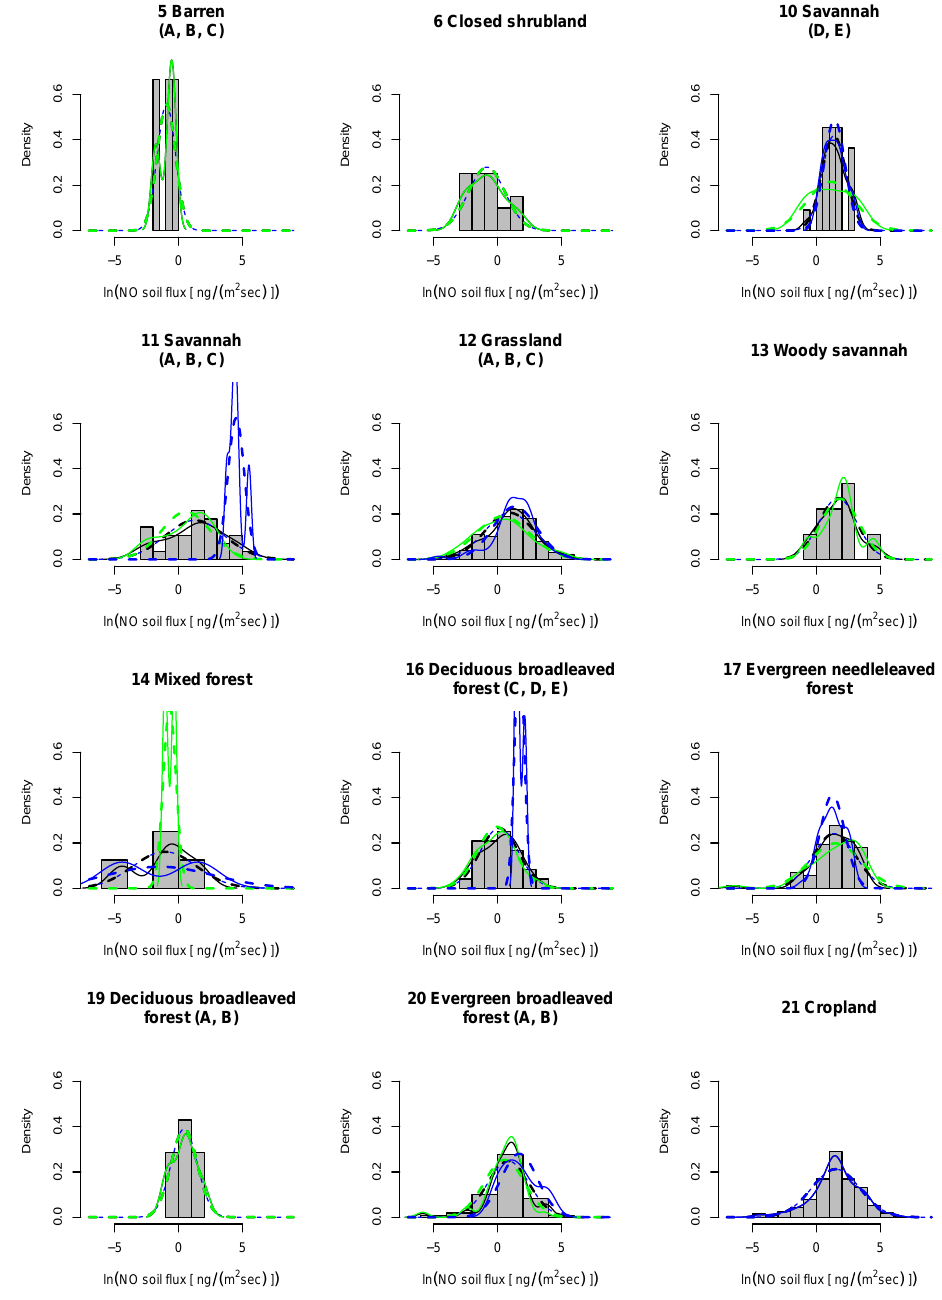
Fig. 3. Logarithmic histogram and probability density function per MODIS landcover and Koeppen main climate class (in brackets) of measured SNO x in the compilation. Color and line type as in Fig. 2.